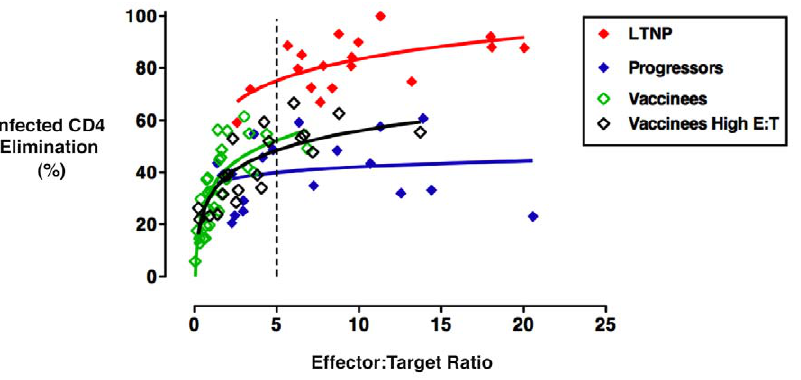
Figure 3. The HIV-specific CD8 + T-cells of Ad5/HIV vaccinees exhibited per-cell cytotoxic capacity that was significantly lower than that of LTNP but only somewhat higher than that of progressors. Cytotoxic responses mediated by day 6 CD8 + T-cells were measured by ICE for all individuals at a standard E:T ratio of 25:1 or an increased E:T ratio of 50:1 (total day 6 CD8 + T-cells to total CD4 + T-cell targets) and subsequently plotted against the true E:T ratios based on measurements of IFN- c -secreting CD8 + T-cells and p24-expressing target cells, respectively. Curves represent trends for responses of LTNP (n=18, red), viremic progressors (n=19, blue), Ad5/HIV vaccinees measured at the standard E:T ratio of 25:1 (n=31, open green) and a subset of Ad5/HIV vaccinees also measured at an increased E:T ratio of 50:1 (n=20, open black). Regression analysis, analysis of covariance and repeated measures were used to quantify the differences in ICE among LTNP, progressors and Ad5/HIV vaccinees over the range of logged E:T ratios, at the median log E:T ratio of the combined groups and at the log E:T ratio of 5:1. ICE of LTNP differed by constant amounts from that of vaccinees over the shared range of true E:T ratios measured with either standard (p , 0.001) or increased (p , 0.001) numbers of CD8 + T-cells. However, the differences between progressor and vaccinee ICE trend lines at standard (p=0.02) and increased (p=0.05) numbers of CD8 + T-cells depended on the value of the E:T ratio over the shared range. See text for more details.